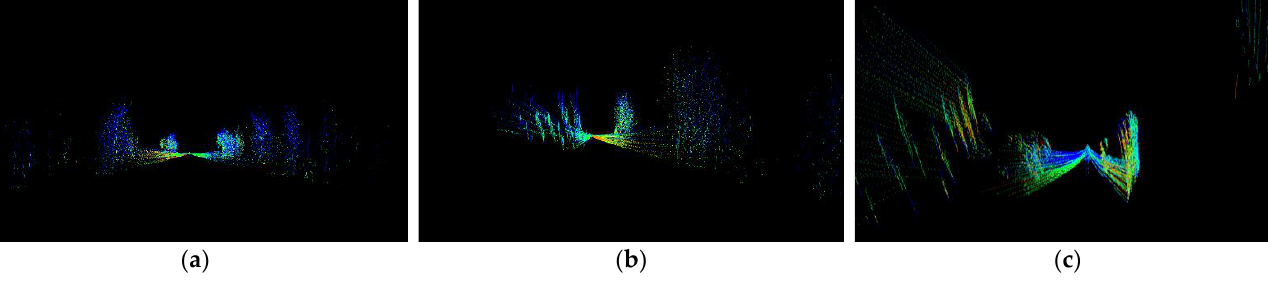
Figure 8. Point cloud image scene 4: Shenandoah-4-fast ( a ) Picture 1, ( b ) Picture 2, ( c ) Picture 3.